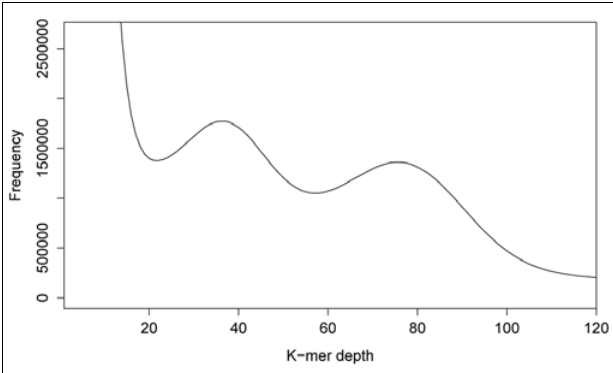
FIGURE 1 | K-mer analysis for P. pachyrhizi whole-genome sequencing data. The 17-mer distribution for 47 Gb of 100 bp paired-end Illumina whole-genome sequencing data indicates two peaks at a depth of 37 and 75.These findings point to a possibly highly repetitive genome with a high degree of heterozygosity between the genomes of the two haploid